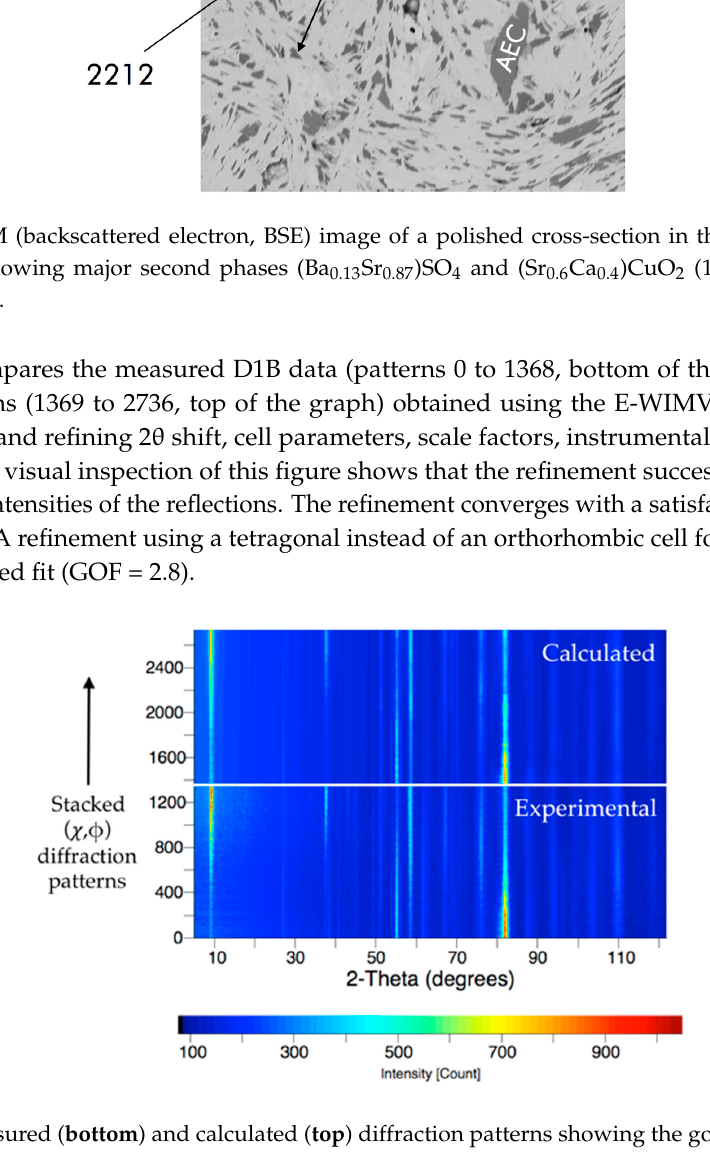
Figure 3. Measured ( bottom ) and calculated ( top ) diffraction patterns showing the good refinement quality using combined analysis [16]. All ( χ , φ ) diffraction patterns are stacked along the vertical axis, with intensity given as a color code according to the bottom bar.